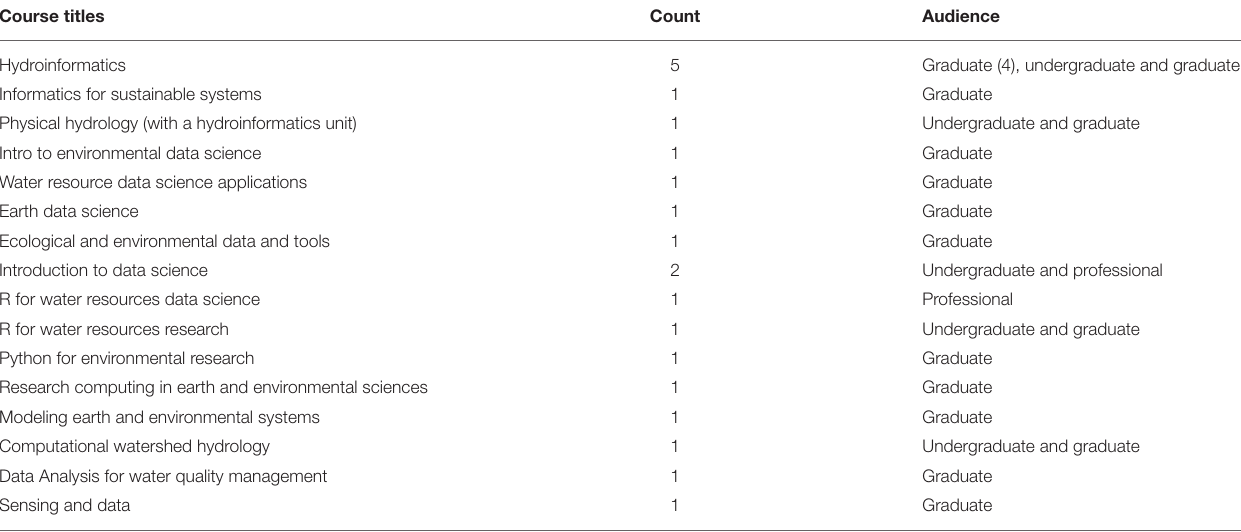
TABLE 2 | Courses taught by study